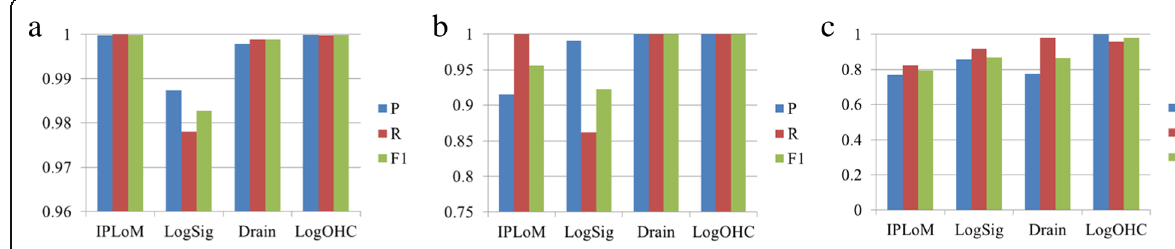
Fig. 7 Comparison of the LogOHC and the other methods on 2kBGL ( a ), 2kHDFS ( b ), and 2kHPC ( c )